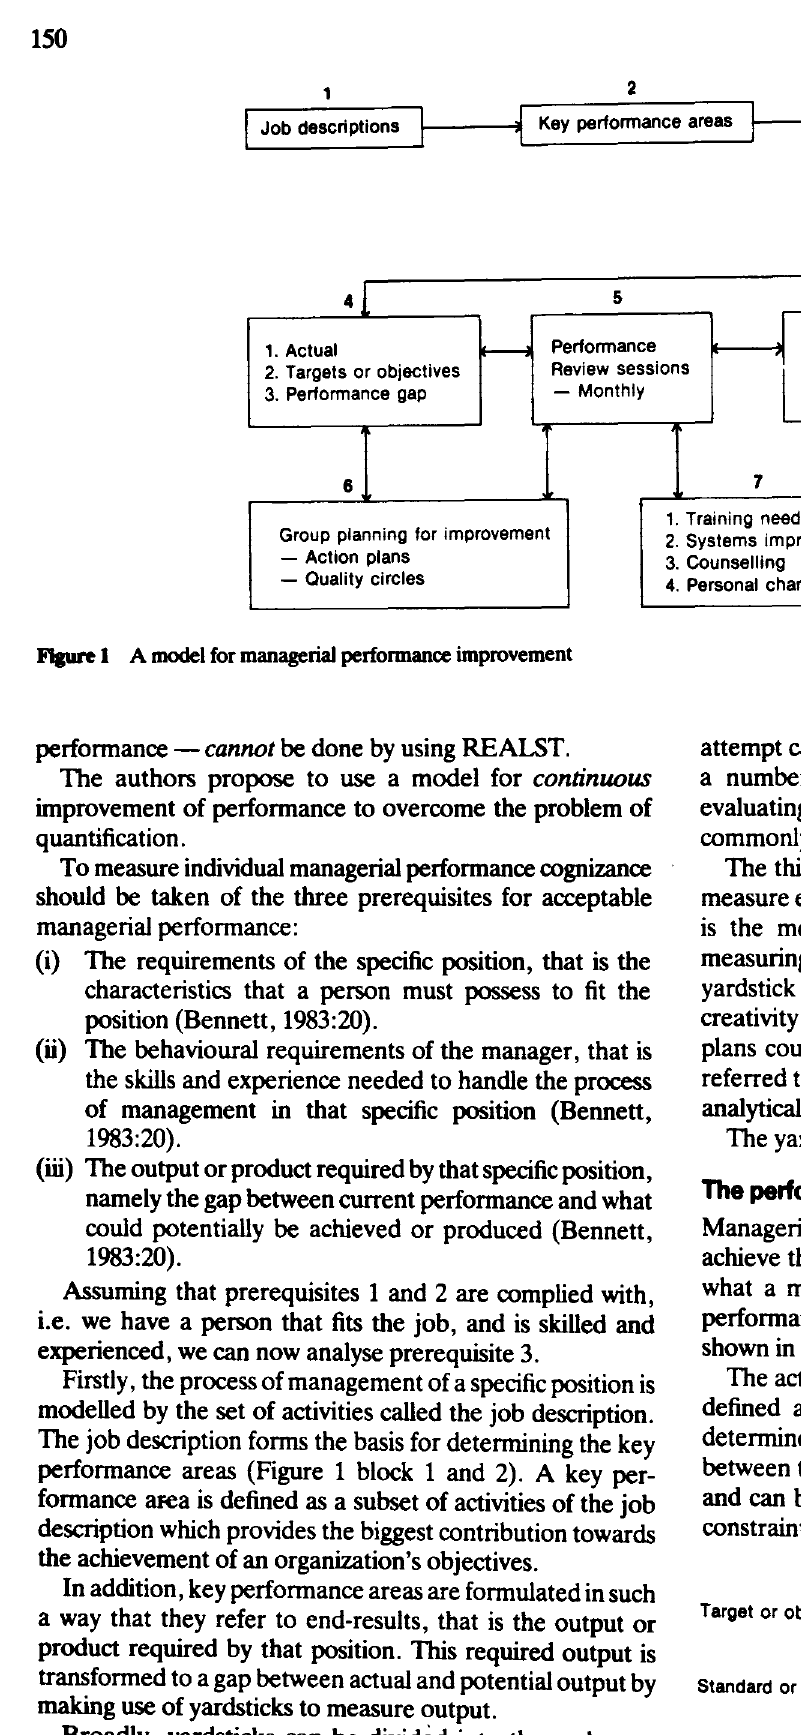
Figure 1 A model for managerial performance improvement